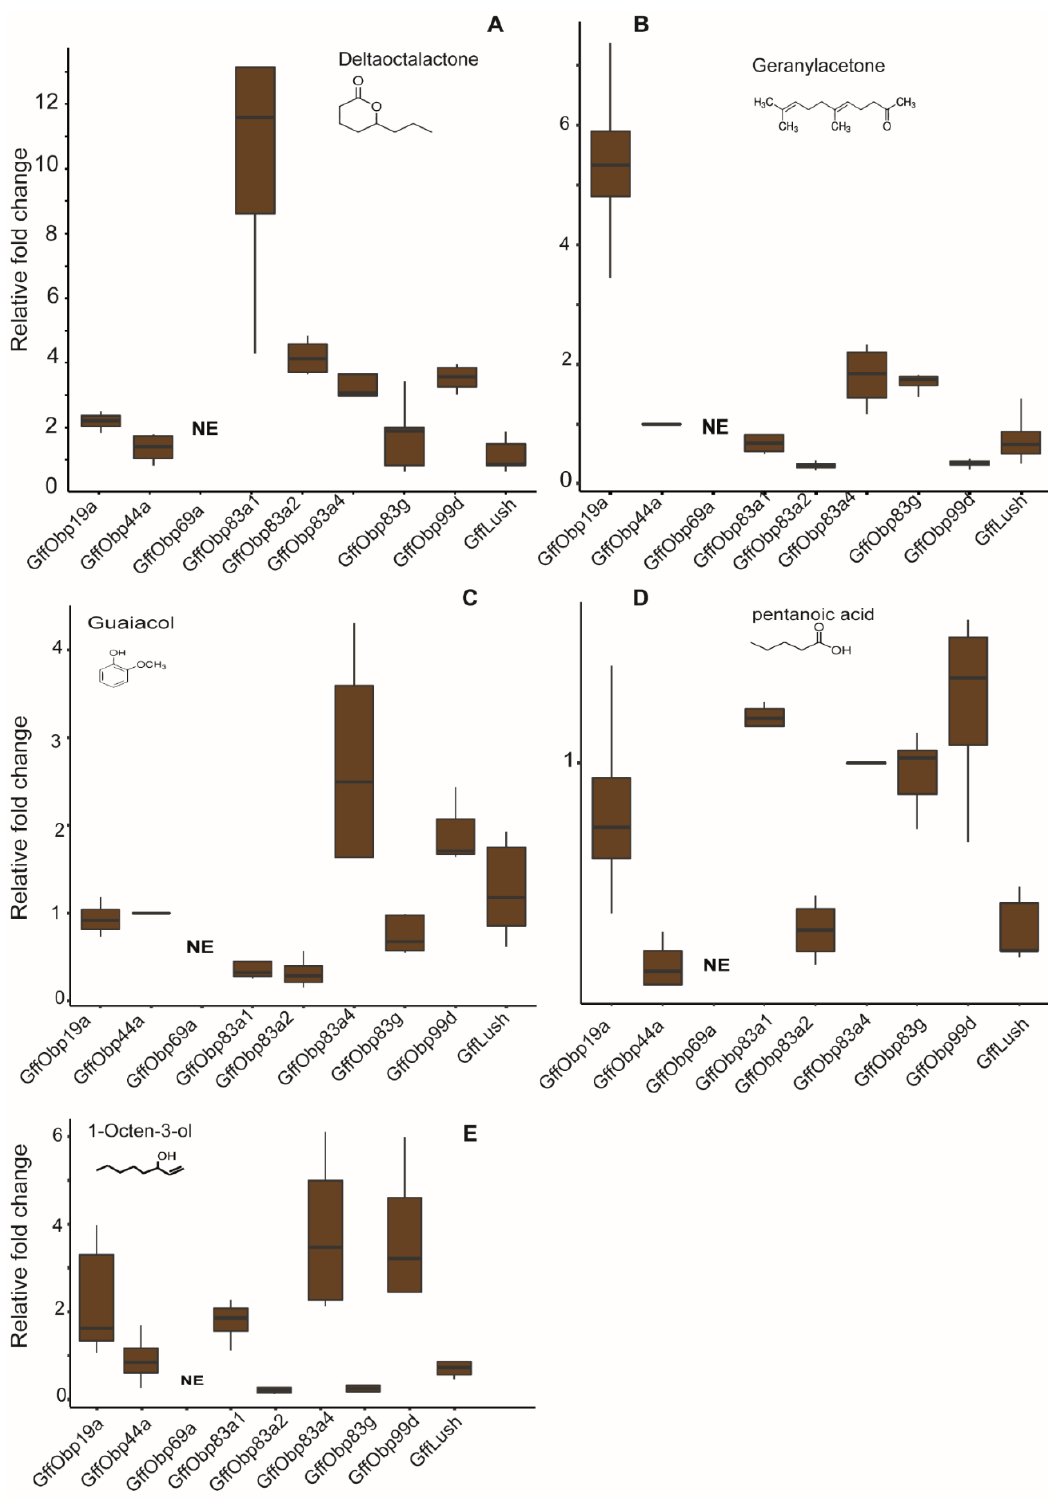
Figure 7. mRNA transcript change patterns when the flies were exposed to different chemicals. ( A – E ) Boxplots illustrating the relative fold change when ( A ) flies were exposed to δ -octalactone, ( B ) flies were exposed to geranyl acetone, ( C ) flies were exposed to guaiacol, ( D ), flies were exposed to pentanoic acid and ( E ) flies were exposed to 1-octen-3-ol. NE means that OBPs were not expressed in the antenna.